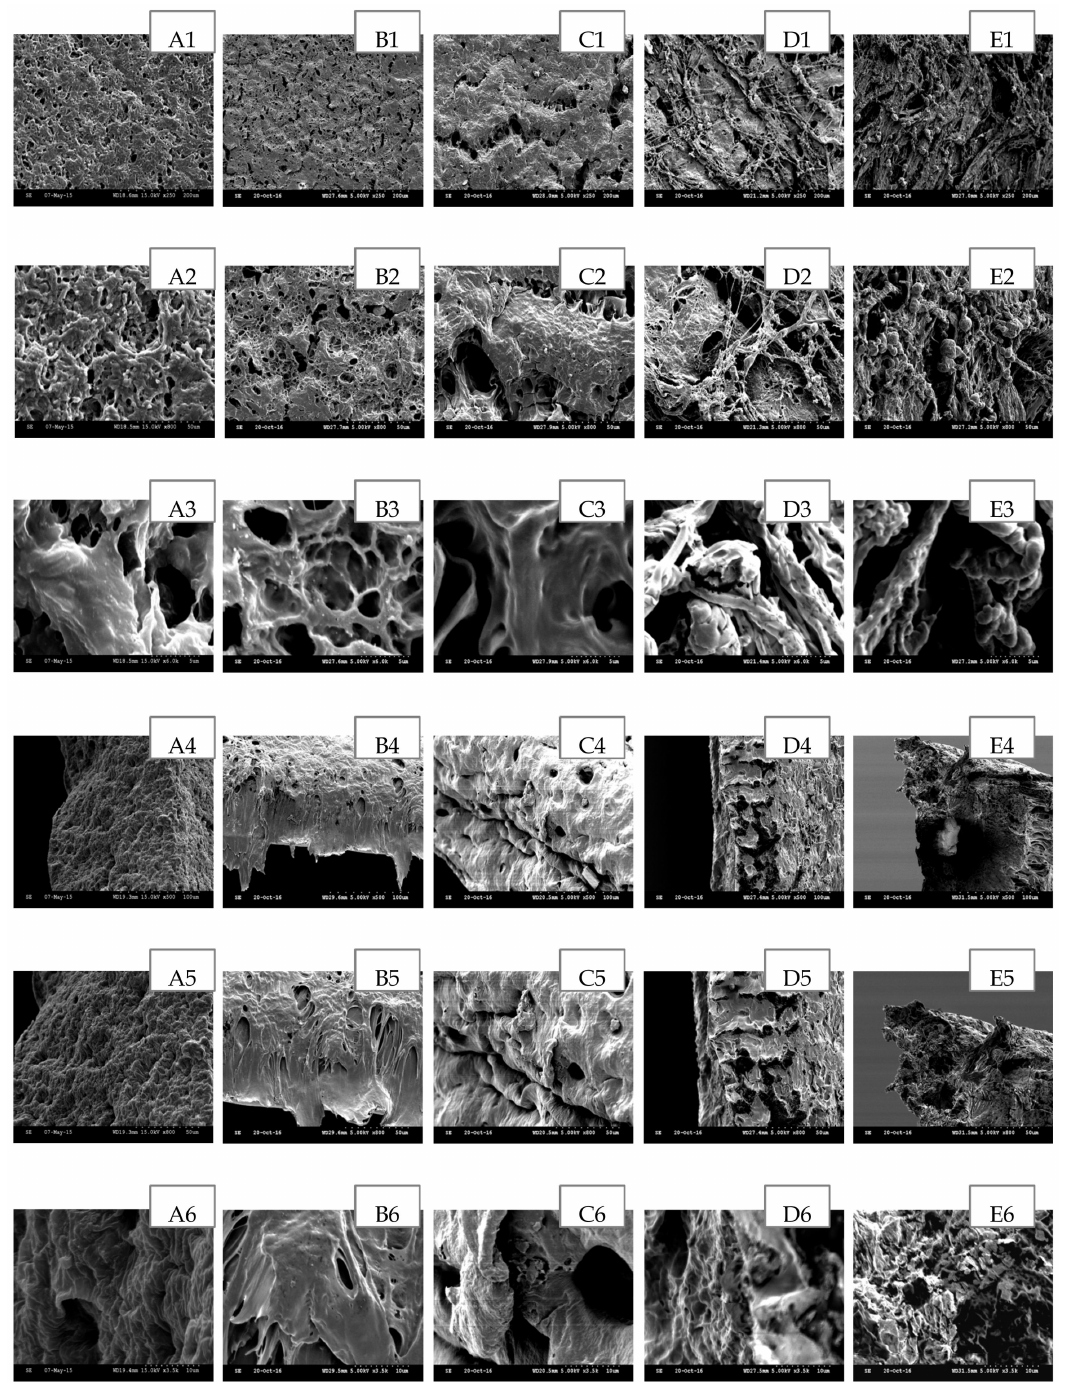
Figure 5. SEM images of in situ loaded LID hydrogel network in comparison to unmedicated hydrogel cross-linked with 5% w / w PETRA. ( A ) Unmedicated PEO, ( B ) PEO-LID 1.12% w / w , ( C ) PEO-LID 3.57% w / w , ( D ) PEO-LID 6.30% w / w , ( E ) PEO-LID 9.93% w / w . Scale bars are 200, 50, and 5 µ m for micrographs featuring the outer surface of hydrogel network (1–3), 100, 50, and 10 µ m for micrographs featuring the cross section of hydrogel network